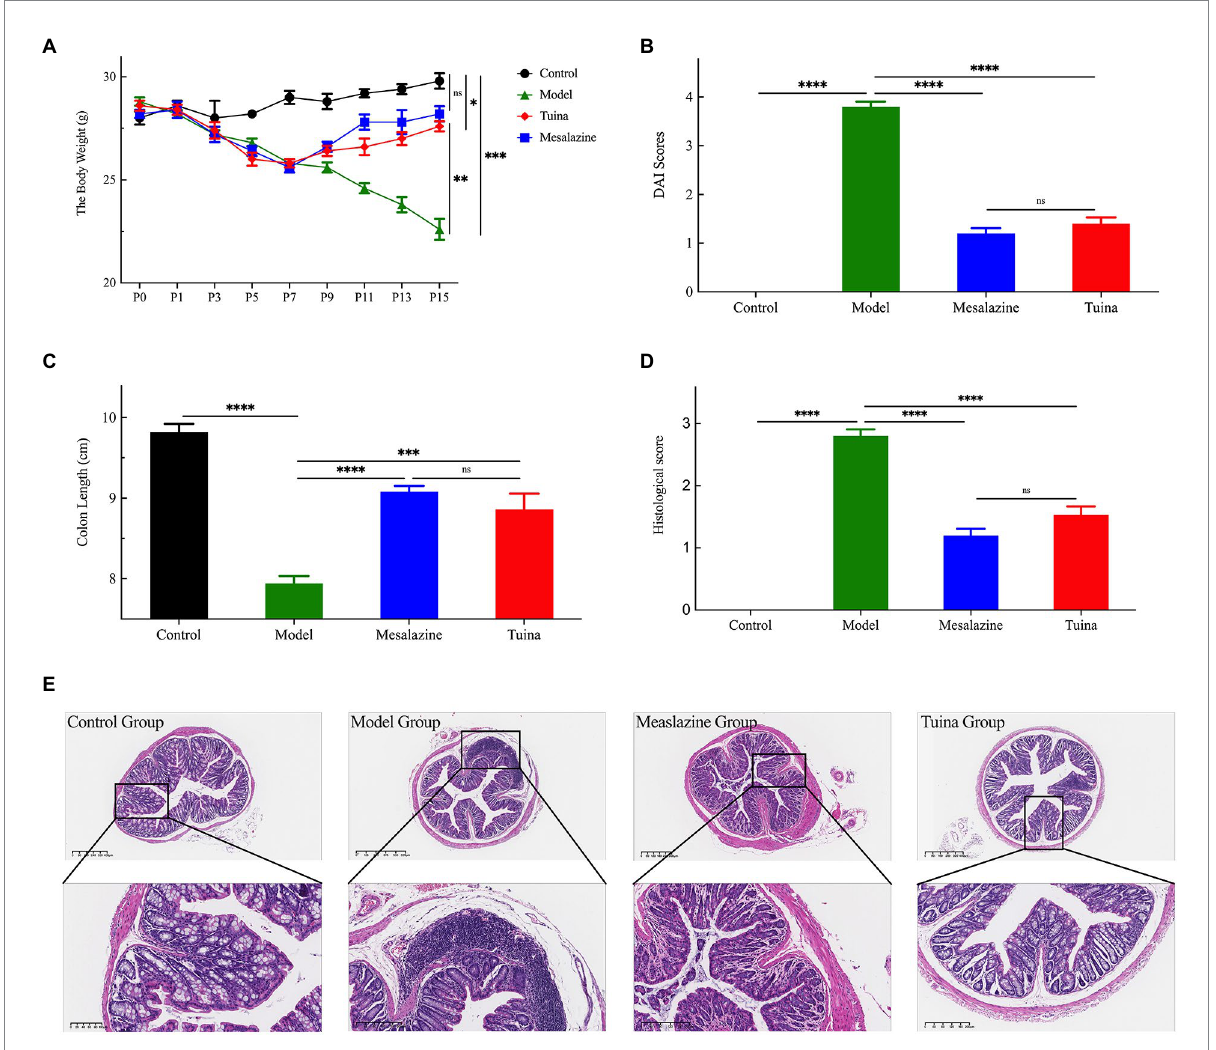
FIGURE 2 Tuina treatment prevents UC-related symptoms in model mice. (A) Changes in body weight of all groups throughout the study. (B) DAI score for each group. (C) The colon length of all groups. (D) Colon histological score of all groups. (E) The HE staining analysis, representative images are shown. a p < 0.05, vs. control group; b p < 0.05, vs. model group; c p < 0.05, vs. model